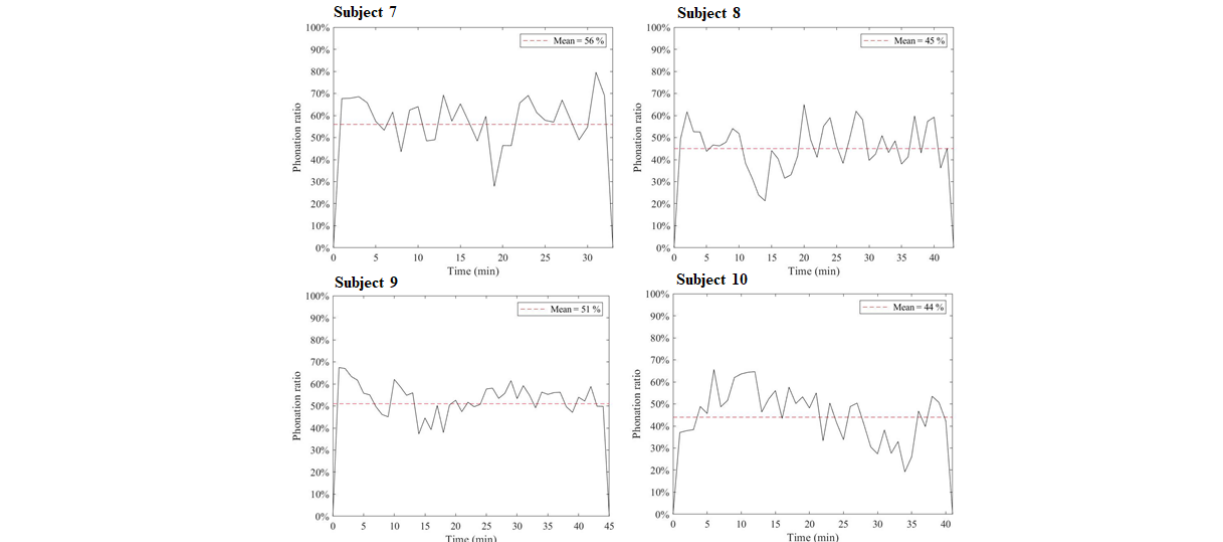
Figure 5. Phonation ratio over time for the 10 teachers (Subjects